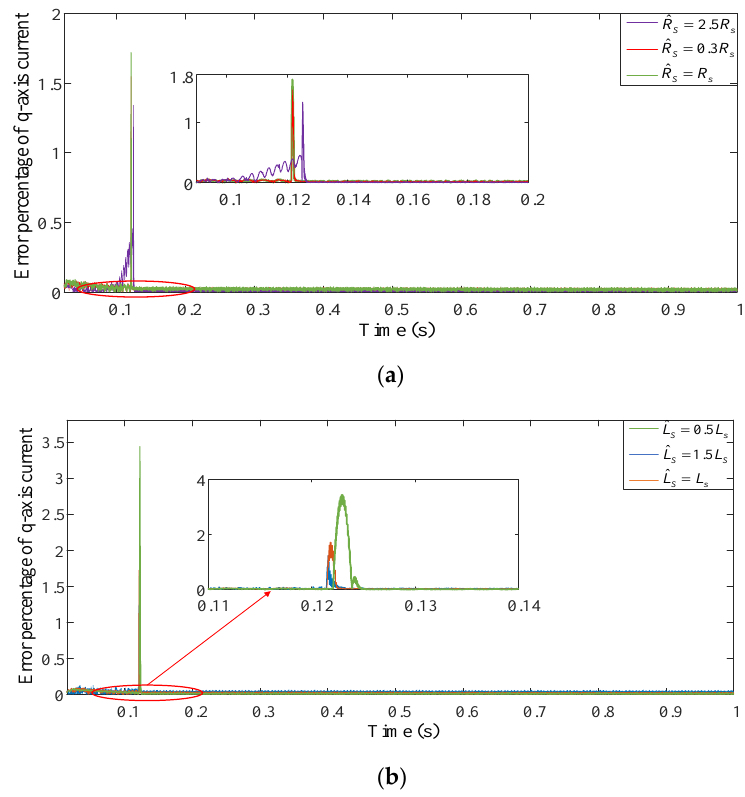
Figure 9. The error percentage of q-axis current under different stator resistances and inductances. ( a ) The error percentage of current under different resistances; ( b ) the error percentage of current under different inductances.